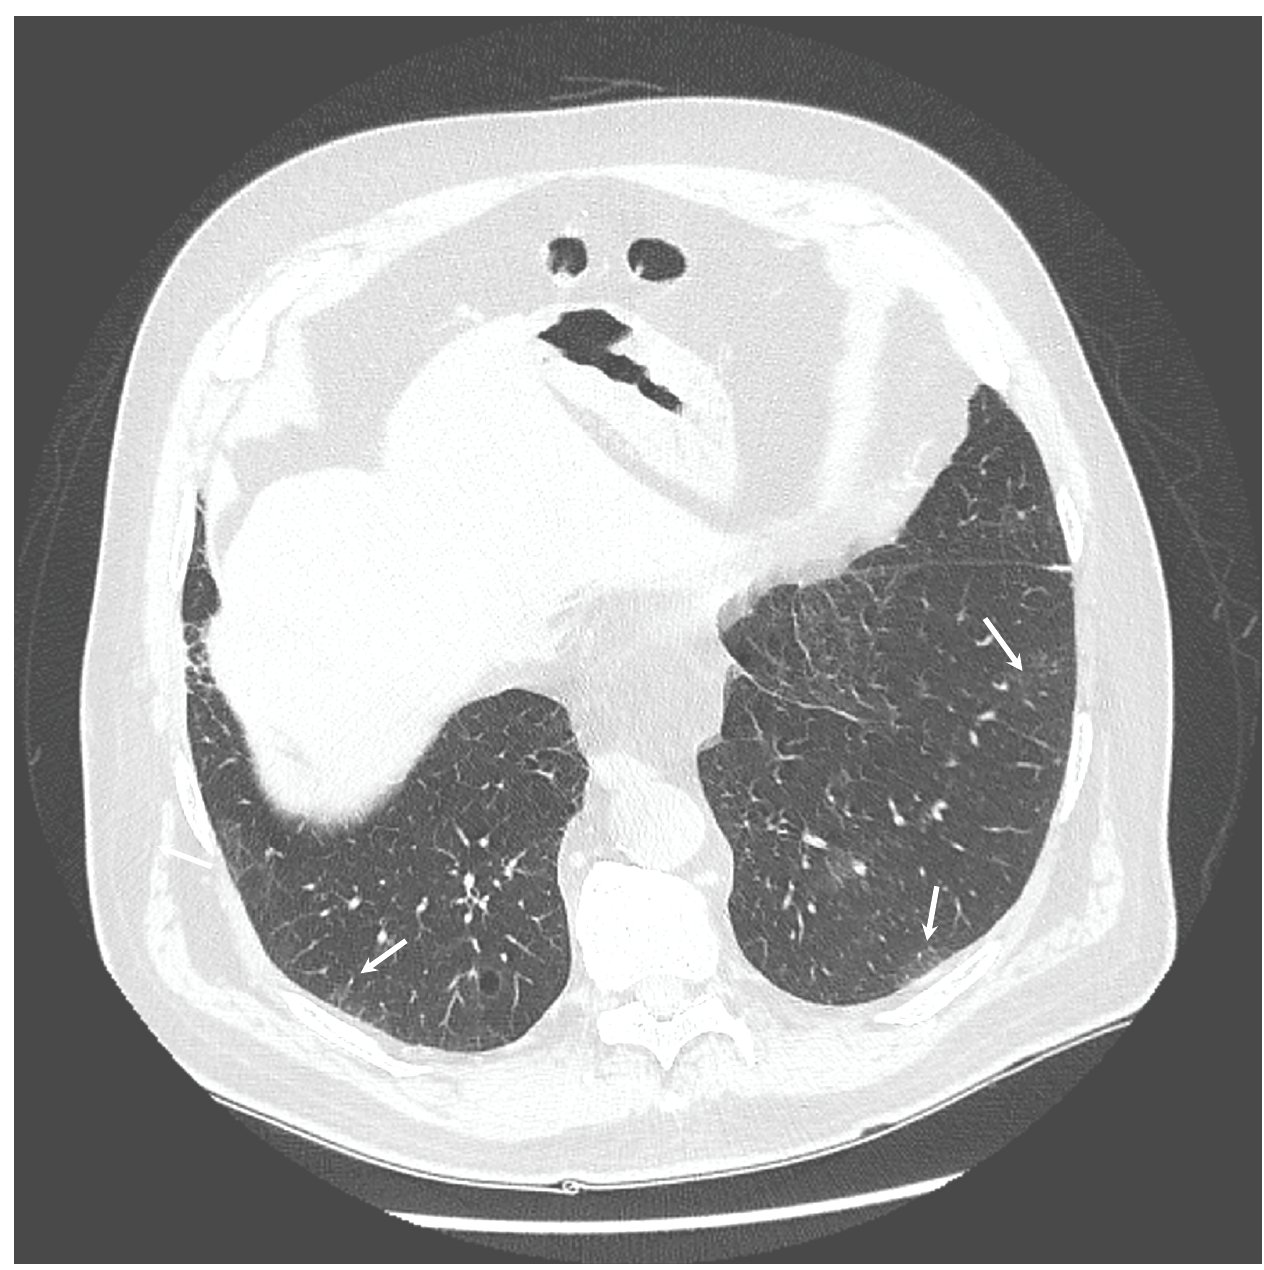
Figure 2. HRCT scan—Secretions accumulation and slight post-inflammatory changes (indicated by the white arrows).